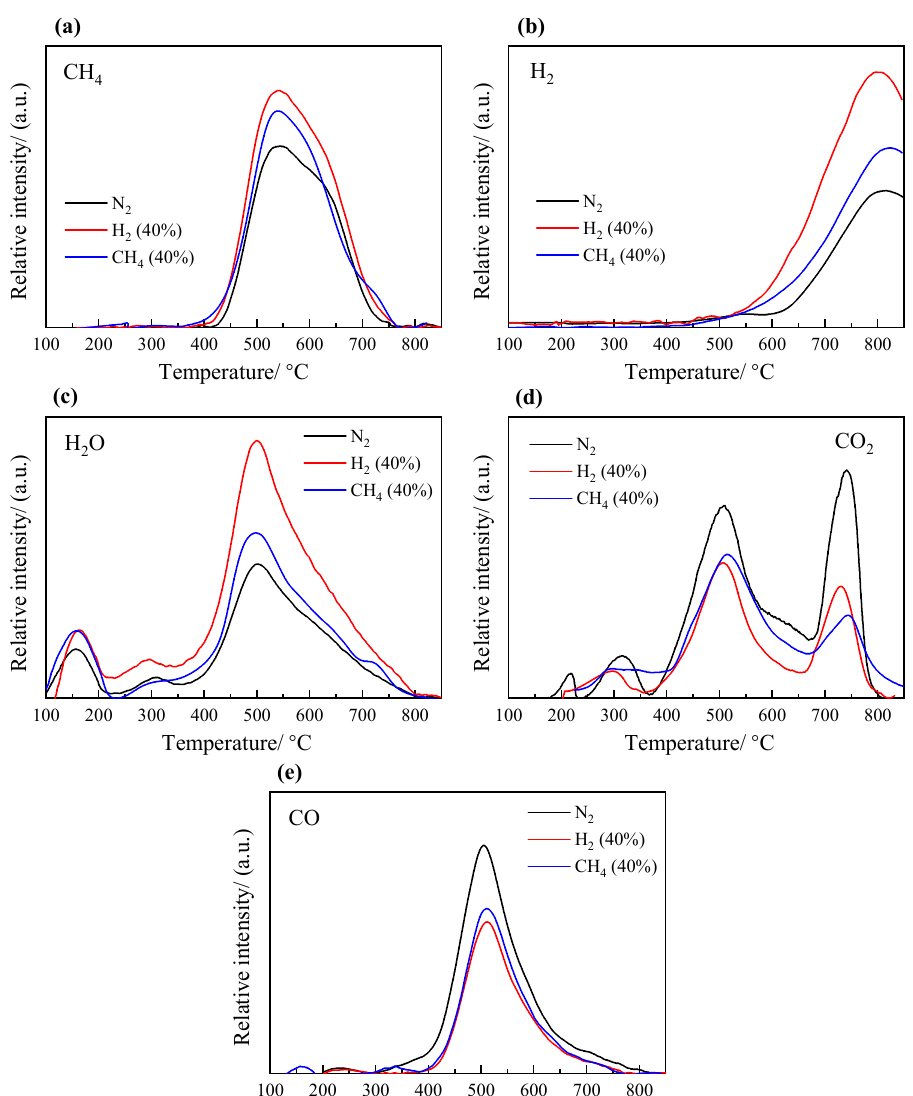
Figure 3. Emission curves of CH 4 , H 2 , H 2 O, CO, and CO 2 during coal pyrolysis in N 2 , H 2 (40%), Figure 3. emission curves of CH and CH 4 (40%): ( a ) CH 4 release curve; ( b ) H 2 release curve; ( c ) H 2 O release curve; ( d ) CO 2 release curve and; ( e ) CO release CH (40%): ( a ) CH 4 and; ( e ) CO release curve.